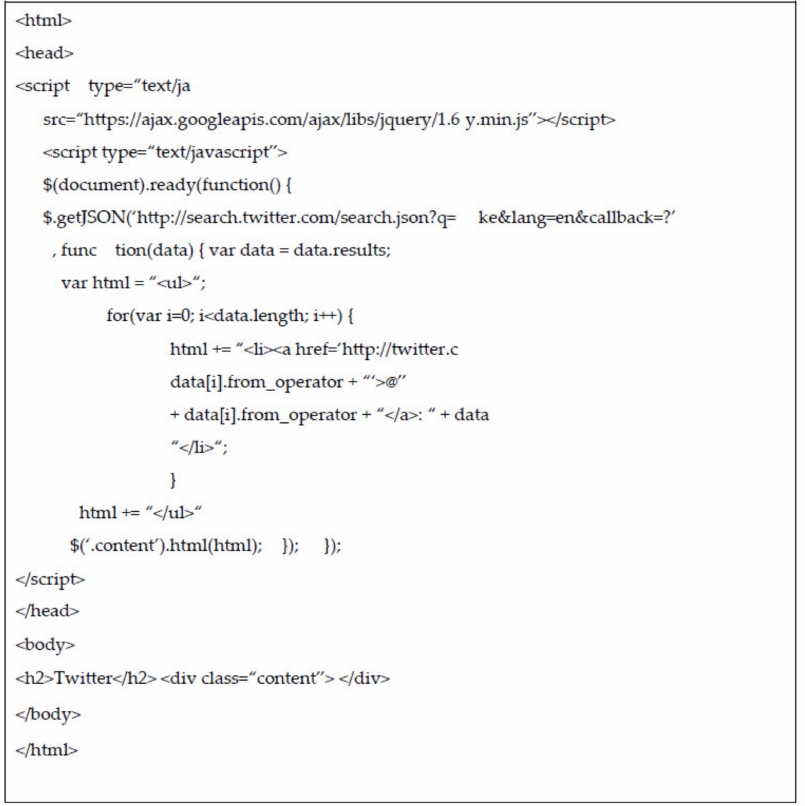
Figure 6. PHP codes for Twitter API data